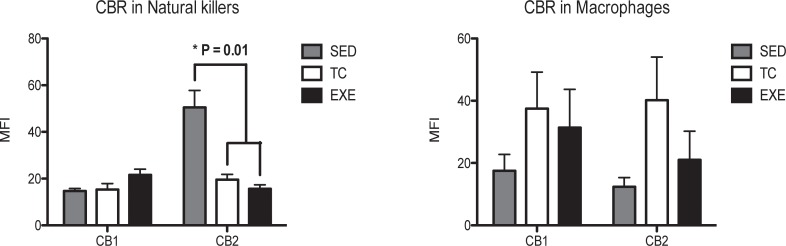
Expression of CBR in splenocyte populations related to the innate immune response.Analysis of the expression of CB1 and CB2 CBR in splenocyte populations from the innate immune response (NK’s and macrophages) among experimental groups: SED (shaded bar), TC (white bar) and EXE (Solid bar); data from 4 independent experiments are expressed as mean ± SE. Lines connecting bars represent comparison among groups, * p<0.05. Two way ANOVA and Bonferroni post-test, n = 9.